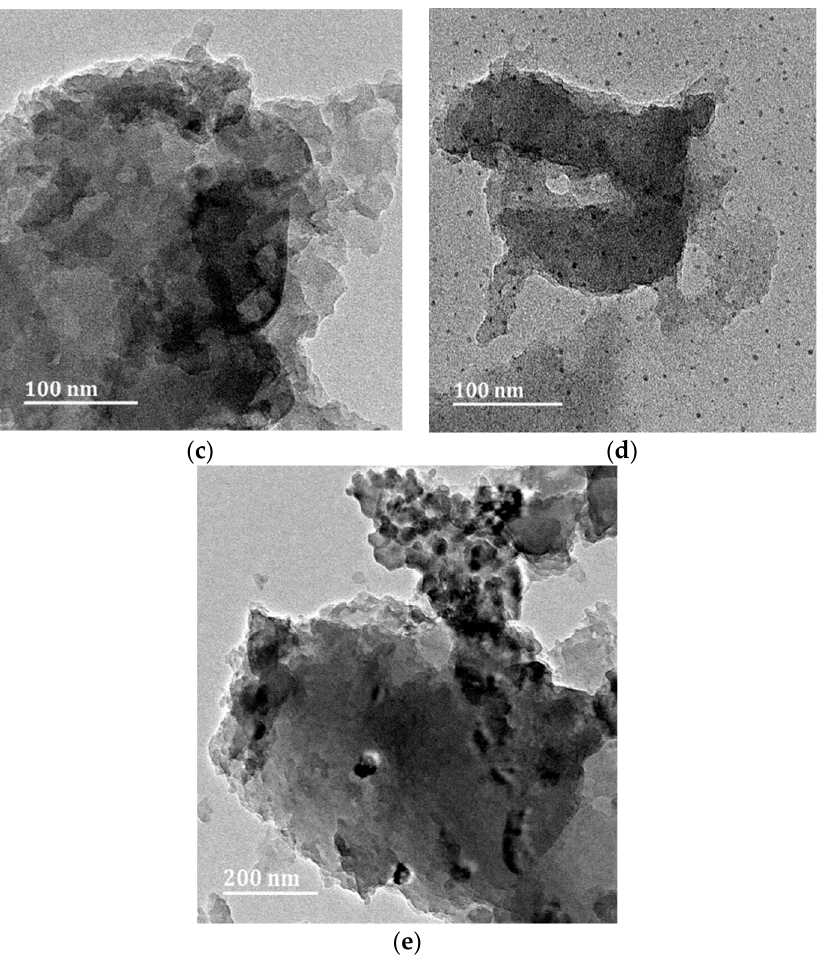
Figure 2. TEM image conducted on a Jeol 2100 HRTEM operating at 200 KV: ( a ) Sample 1, ( b ) Sample 2, ( c ) Sample 3, ( d ) Sample 4, and ( e ) Sample 5 .